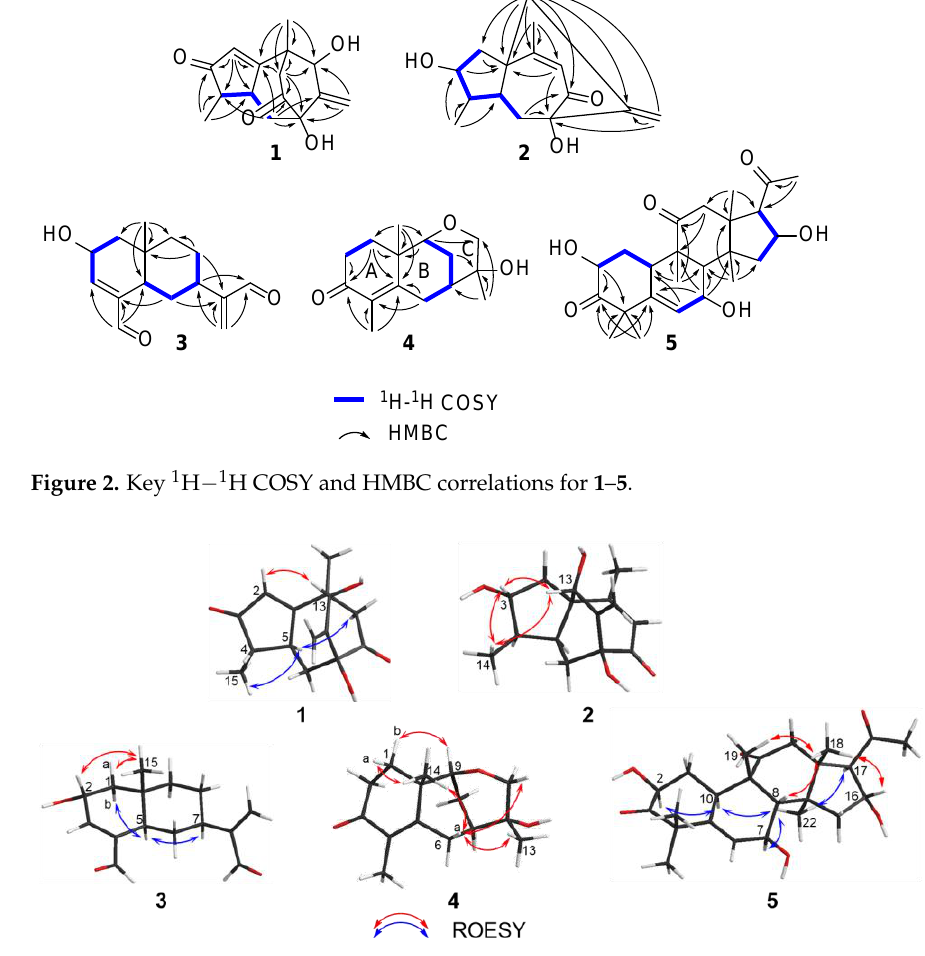
Figure 3. Key ROESY correlations for 1 – 5 .